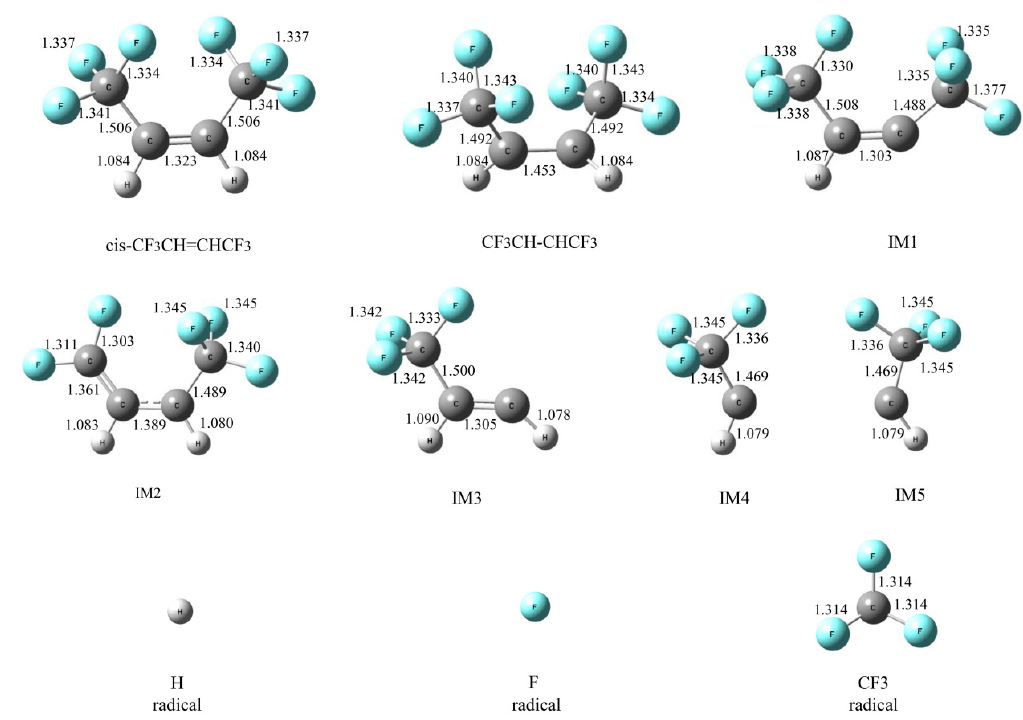
Figure 9. Geometric optimization of transition states, intermediates and radicals at the beginning of HFO ‐ 1336mzz pyrolysis (Z). C, H and F atoms are represented with black, gray and blue balls, respectively.